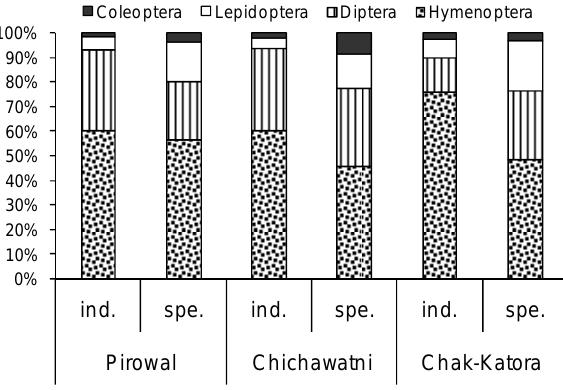
F IGURE 1. Percentage of species (spe.) and individuals (ind.) of related insect orders visiting Prosopis juliflora flowers at three locations in southern Punjab during